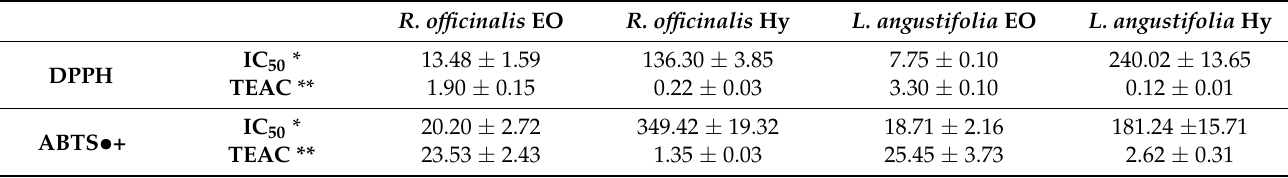
Table 7. Antioxidant activity of R. officinalis and L. angustifolia EOs and